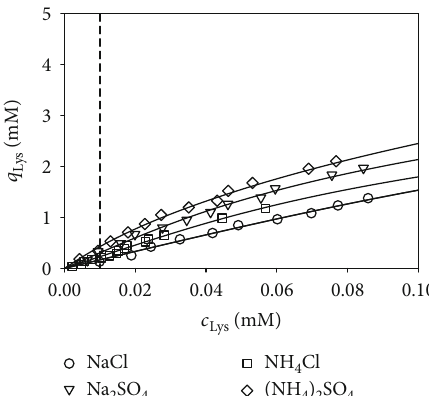
Figure 3: Lysozyme loading q Lys of Toyopearl MX-Trp-650M at c = 0 : 01 mM, pH 7.0, and 25 ° C for all studied salts as a function Lys of ionic strength I . Symbols: experimental results (correlated with Equation (1)). Lines: correlations with Equation